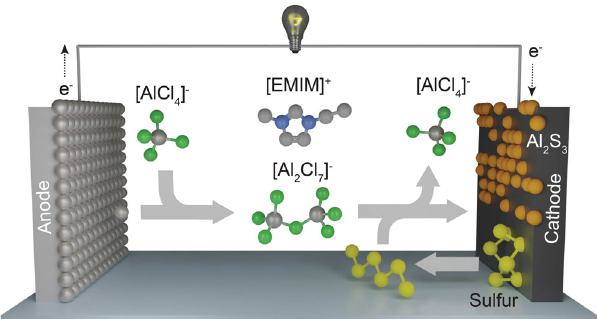
Fig. 4 The con fi guration of an Al – S battery. Schematics of the discharge process in an Al – S